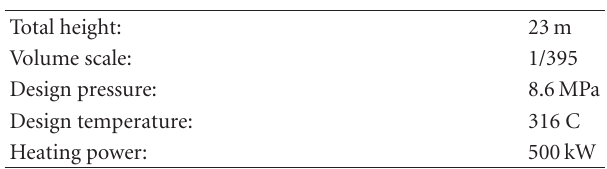
Total height: Volume